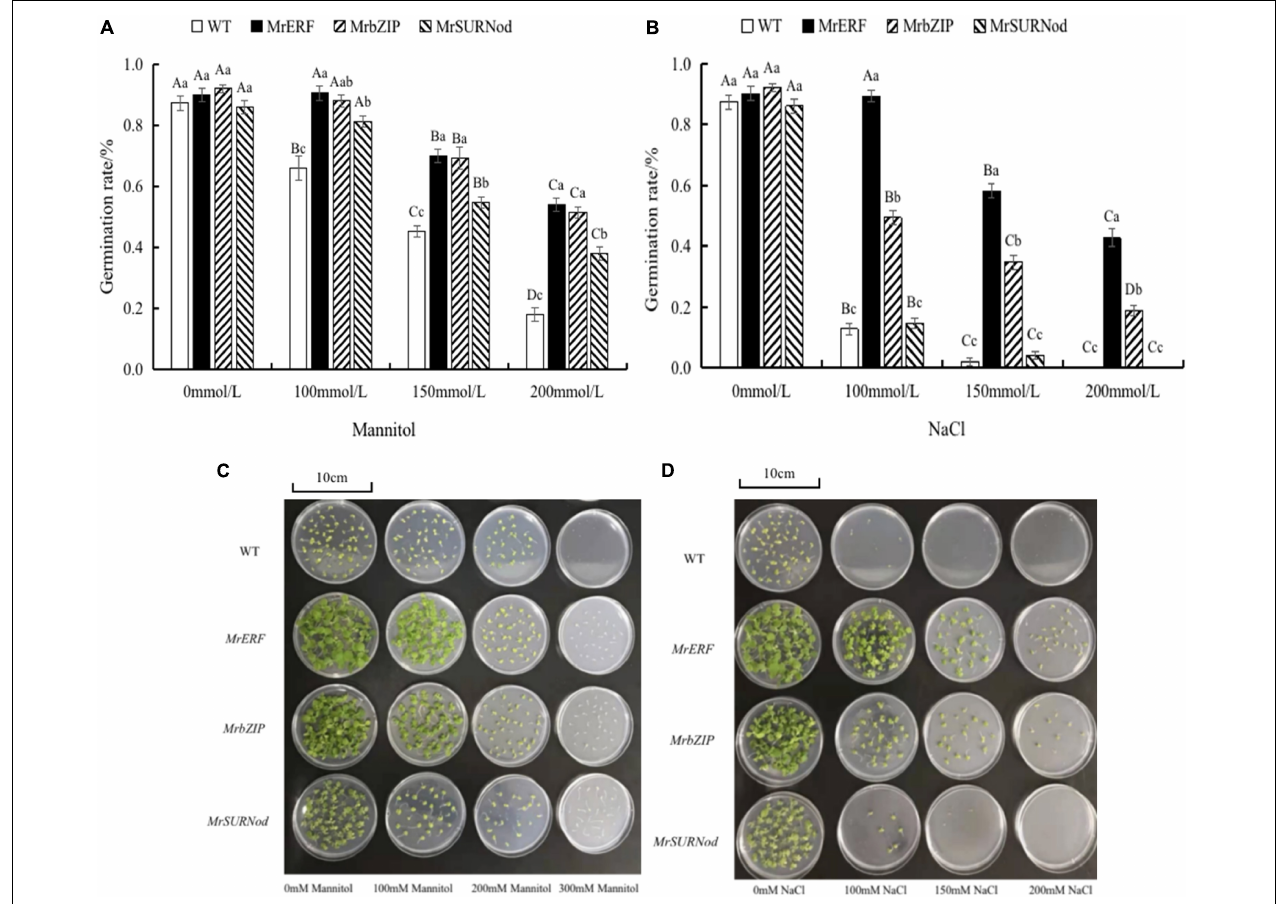
FIGURE 6 | Germination of transgenic tobacco seeds treated with mannitol and NaCl. (A,C) Germination rate of transgenic tobacco seeds under mannitol treatment. (B,D) Germination rate of transgenic tobacco seeds under mannitol NaCl treatment. Different capital letters indicate significant differences under different treatments, and different lowercase letters indicate significant differences among different transgenic lines in the same treatment ( P <